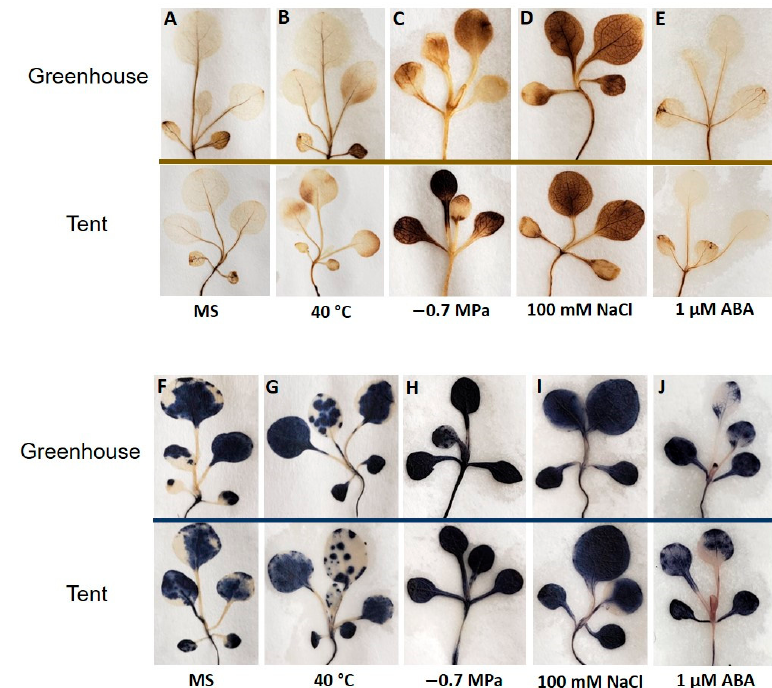
Figure 5. Alteration in reactive oxygen species (ROS) in petunia seedlings in response to different stress treatments. ( A – E ) Representative images of histochemical detection of hydrogen peroxide (H 2 O 2 ) after treatment with high temperature, PEG8000, NaCl, and ABA. ( F – J ) Representative images of histochemical detection of superoxide anion (O 2 − ) after treatment with high temperature, PEG8000, NaCl, and ABA.